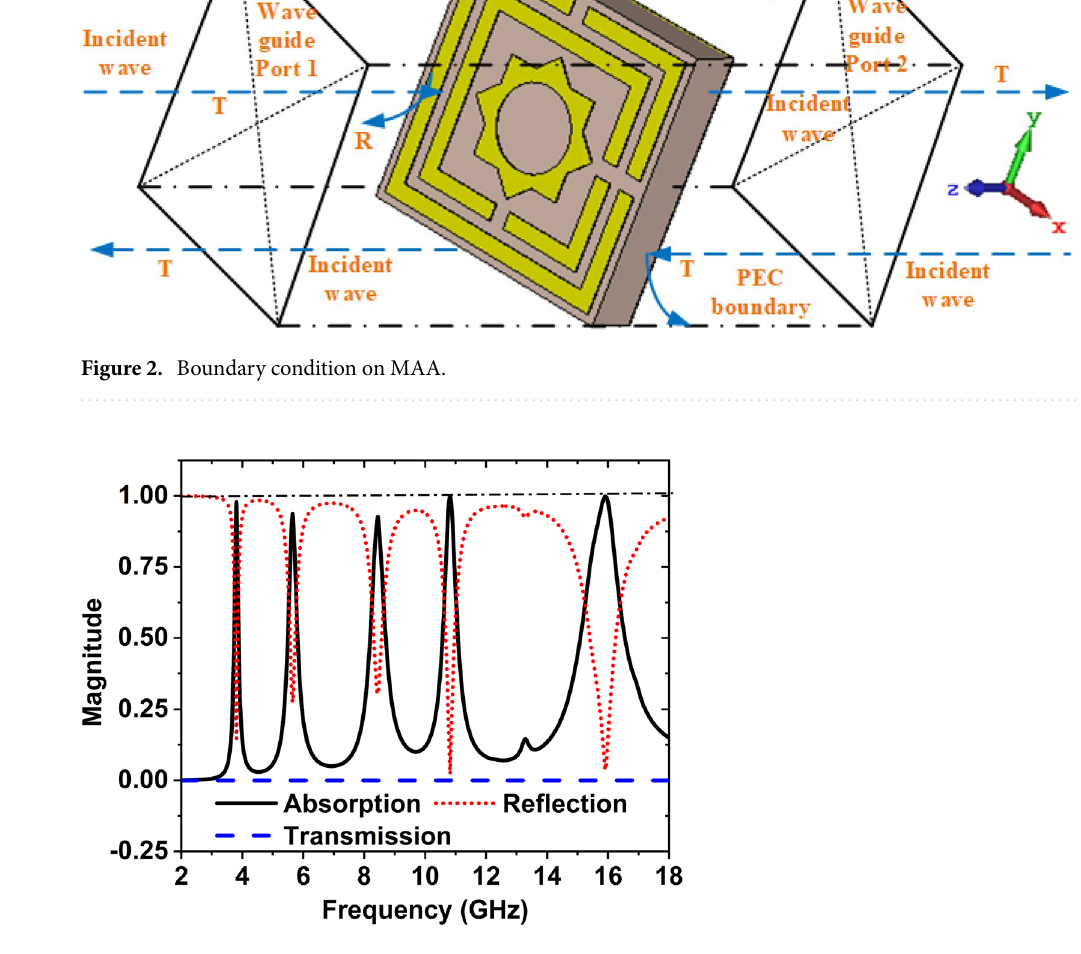
Figure 3. Absorption, reflection, and transmission coefficient of MAA unit